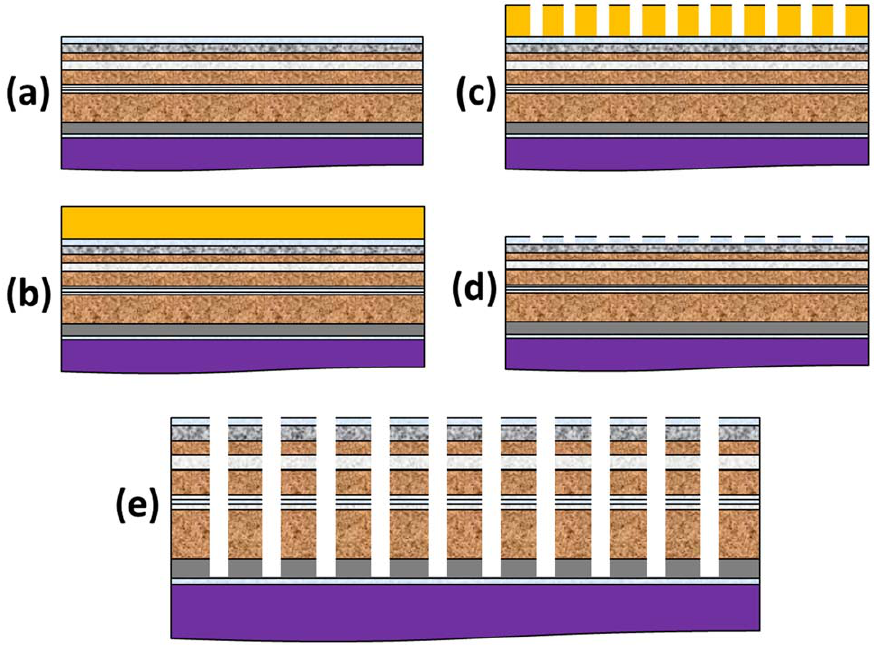
Figure 3. ML-3D BPM media fabrication process. (a) Sputter-deposition of the triple-stack ML-3D magnetic media composition (b) Spin-coat and bake HSQ (c) E-beam lithography (expose and develop patterns) (d) ICP etching of the naturally oxidized Ti layer (e) Ar-ion milling of the remaining composition to form the triple-stack ML-3D BPM.